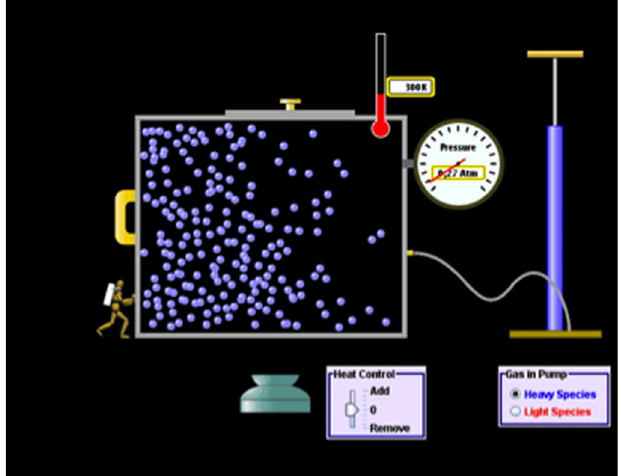
FIG. 1. Screenshot from “ Gas Properties, ” a PhET Interactive Simulation